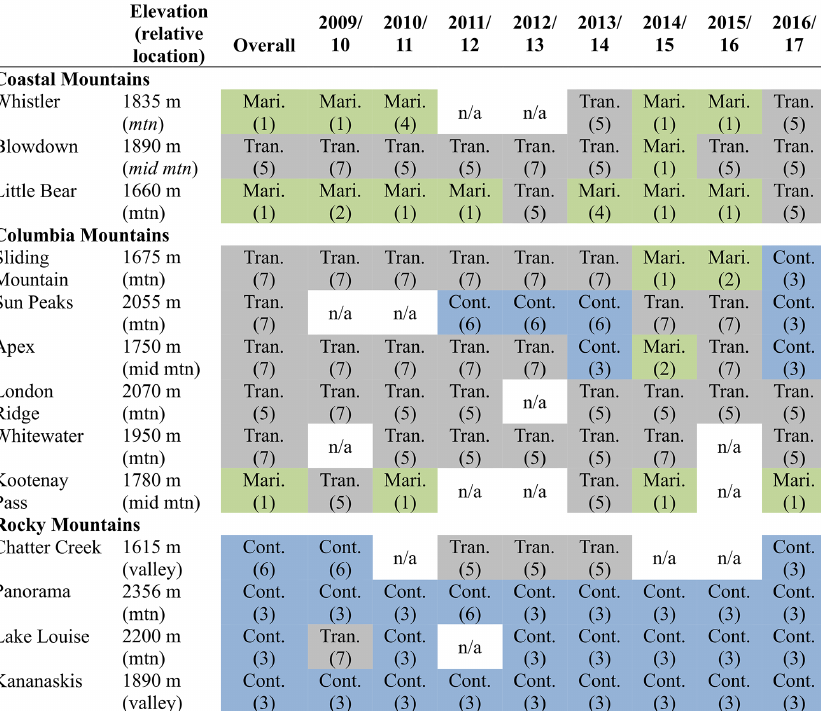
Figure 6. Overall and seasonal snow climate classifications according to Mock and Birkeland (2000): maritime (green), transitional (grey) and continental (blue). The number in each field represents the snow climate decision. Seasons with insufficient weather observations are indicated with